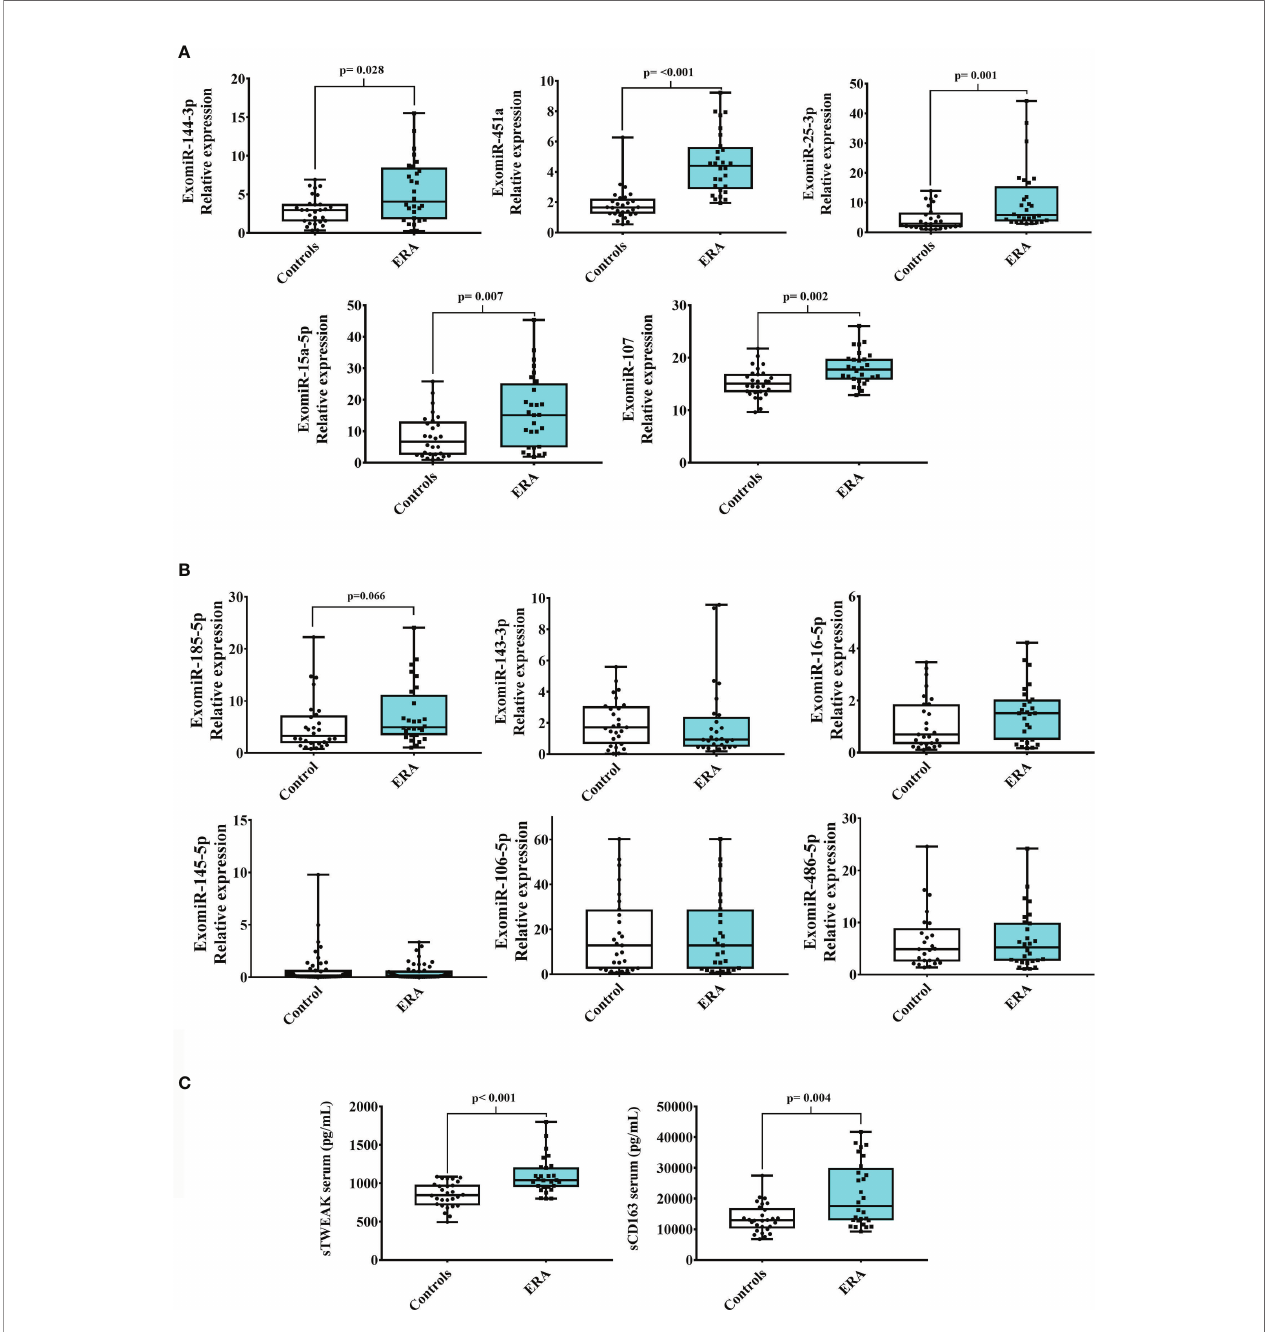
FIGURE 2 | Serum exomiRNAs and in fl ammatory biomarkers in early RA. Validation of 11 selected exomiRNAs from the microarray pilot study of ERA (early RA) and control cohorts. (A) Signi fi cant upregulated exomiRNAs (B) Not-signi fi cantly expressed exomiRNAs. (C) sTWEAK and sCD163 serum circulating levels in patients with ERA and controls. Box plots show the median, quartiles and extreme